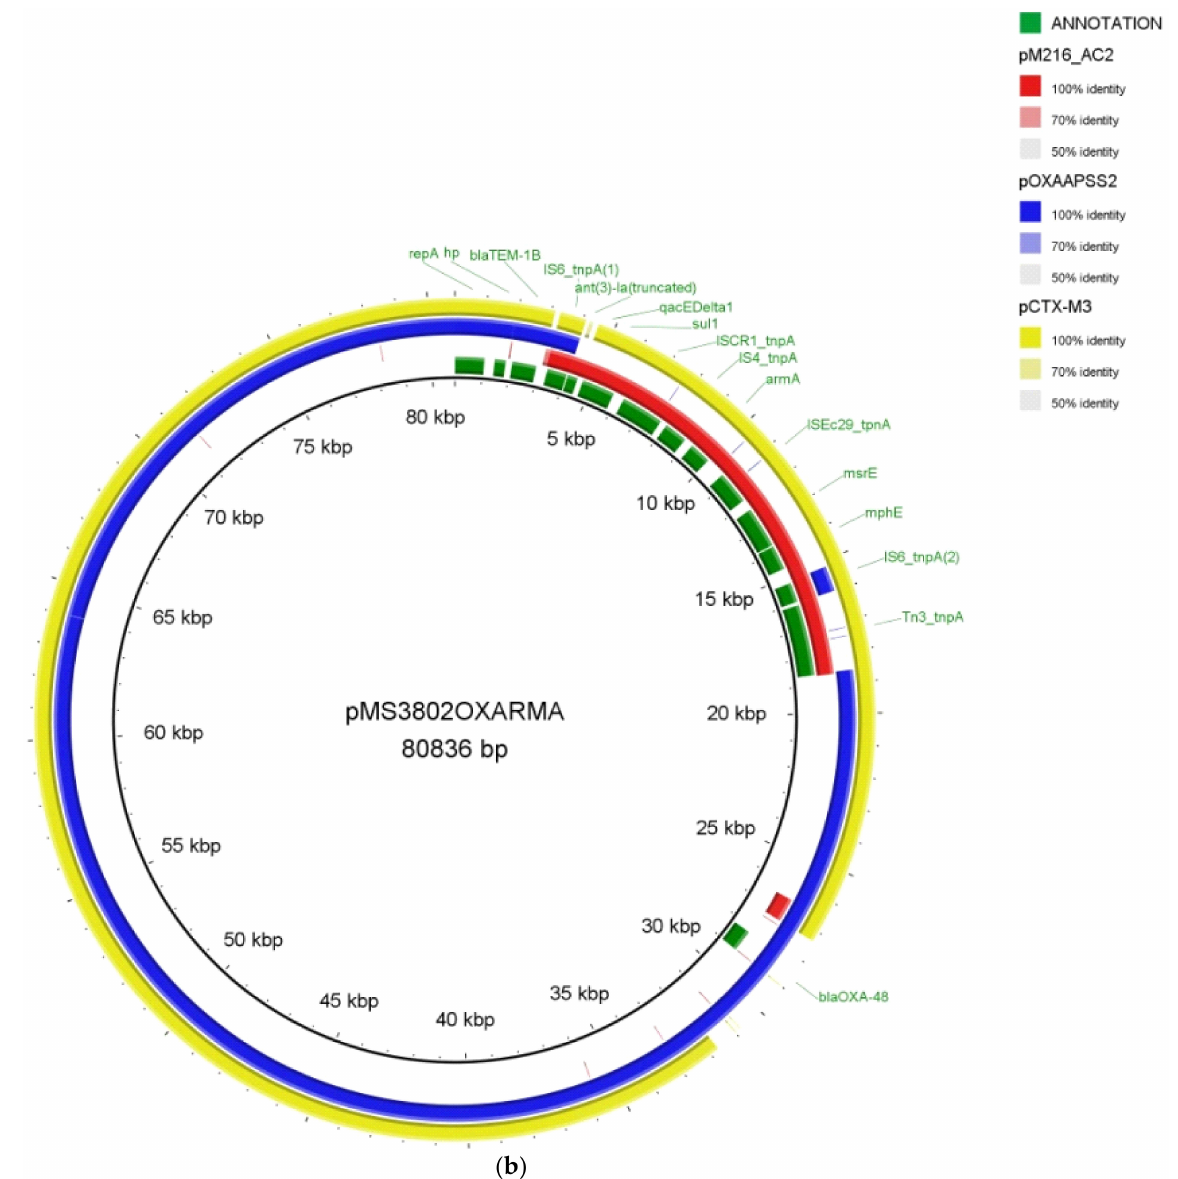
Figure 1. Blast Image Generator (BRIG) analysis of the hybrid virulence/resistance bla CTX-M-15 -carrying plasmid pMS3802-CTX-vir ( a ) and plasmid pMS3802OXARMA containing the bla OXA-48 and armA genes ( b ) found in the XDR K. pneumoniae isolate MS3802. Comparative analysis of plasmids pMS3802-CTX-vir and pMS3802OXARMA with closely related plasmids using the BLAST Ring Image Generator is shown in each case. The concentric rings display similarity between the reference sequence in the inner ring and the other sequences in the outer rings. The different colour levels indicate a BLASTn result with a matched degree of shared regions, as shown to the right of each plasmid